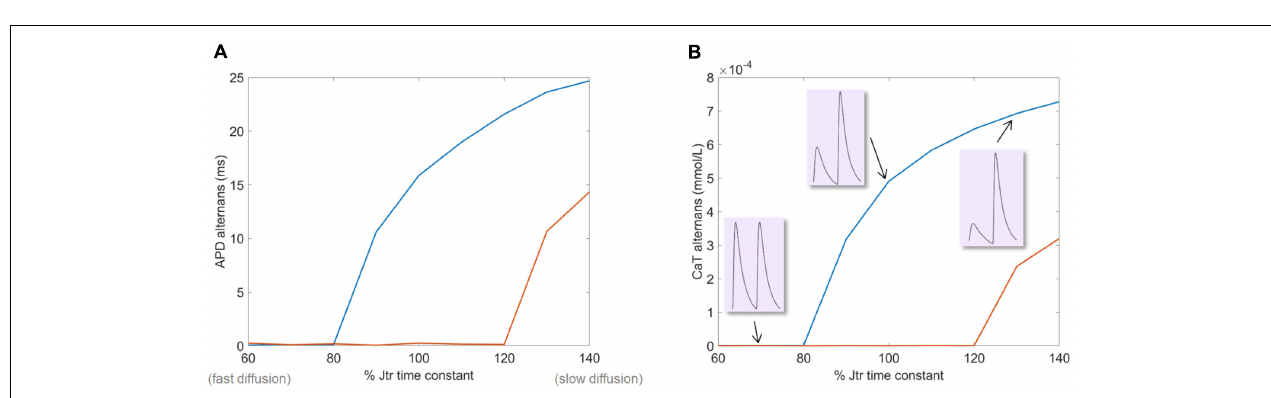
FIGURE 3 | Near-linear relationship between I CaL multiplier and total SR release in the HeRd and ORd models. Shown are results in the HeRd model (A) and the ORd model, endocardial, and epicardial (B) . Relative increase in total SR release (J rel integral) for a given I CaL scaling factor is given as follows: let x be an I CaL scaling factor and y be the resulting integral of J rel over two action potentials after stable-state pre-pacing. Let a be the integral of J rel over 2 APs for I CaL scaling factor of 1. Then, relative J rel integral is y / b . Integral over 2 APs is used to accommodate for alternans formation. In all cases, the model was paced until steady state for 2500 beats at bcl 260 ms.